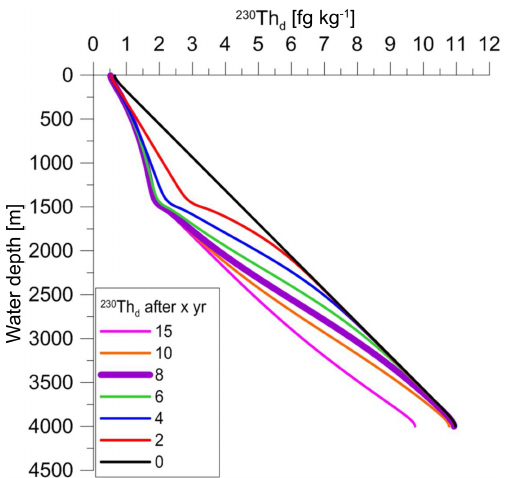
Figure 6. Modelled dissolved 230 Th distribution in the Amundsen Basin 0, 2, 4, 6, 8, 10, 15 and 20 years after the reduction in concen- tration in the upper layer (0–1500m) by continuous exchange with 230 Th-free surface water. The model was modified after Rutgers van der Loeff et al.